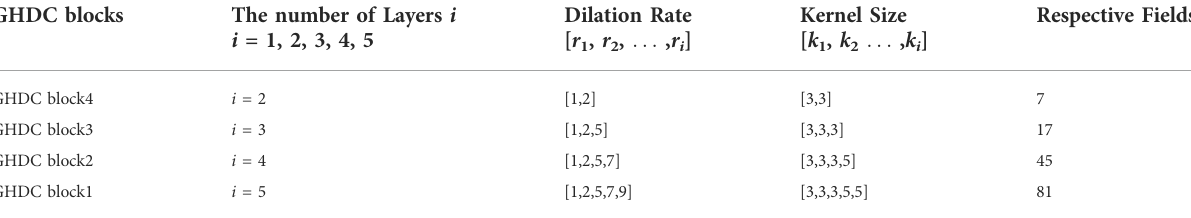
TABLE 1 The arguments for the GHDC blocks in the proposed N-Net. GHDC blocks The number of Layers i